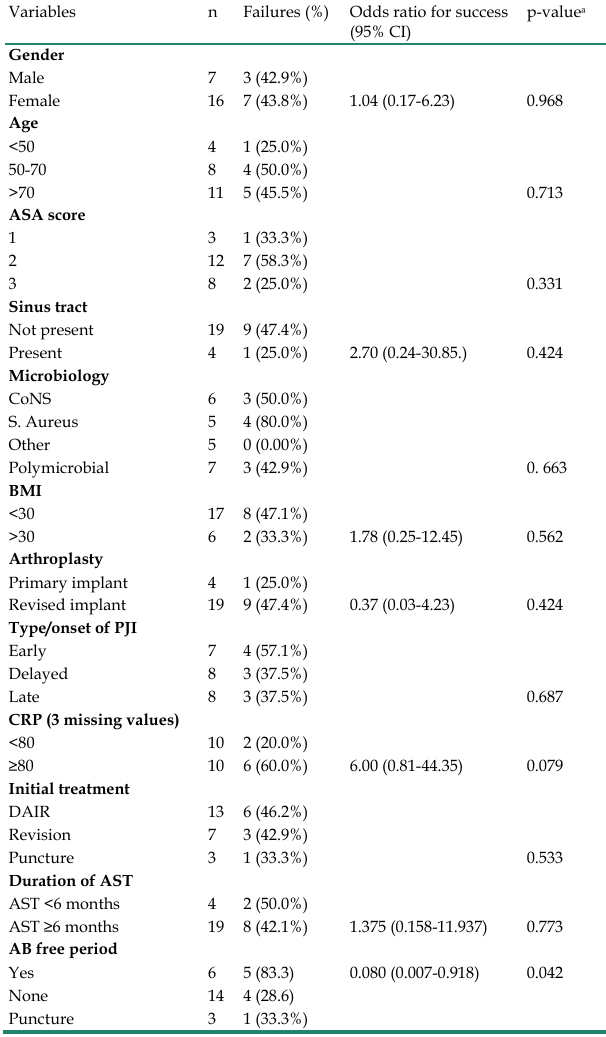
Table 3. Univariate regression